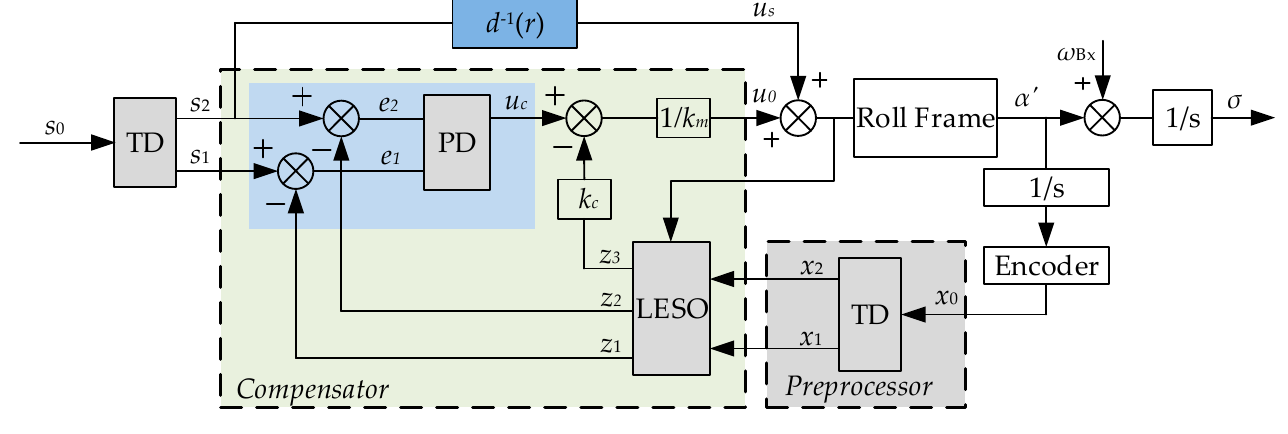
Figure 5. The scheme of the proposed controller in the roll frame.